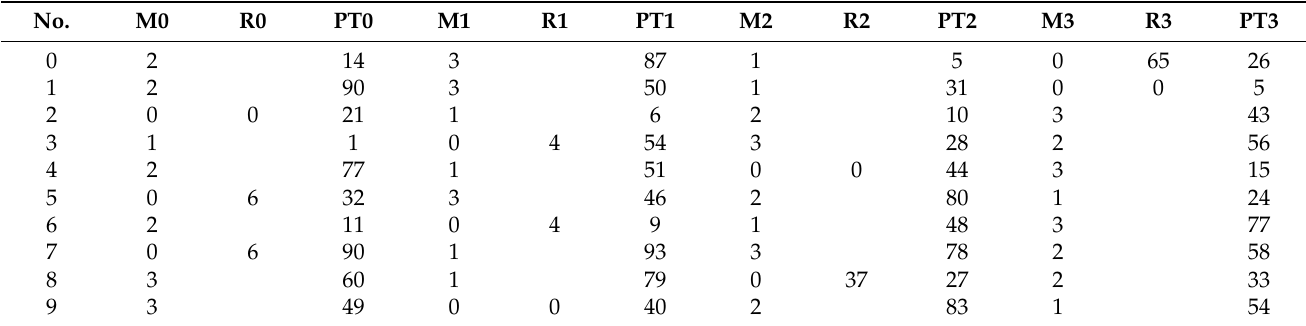
Table 4. Manufacturing system data example (four machines and ten